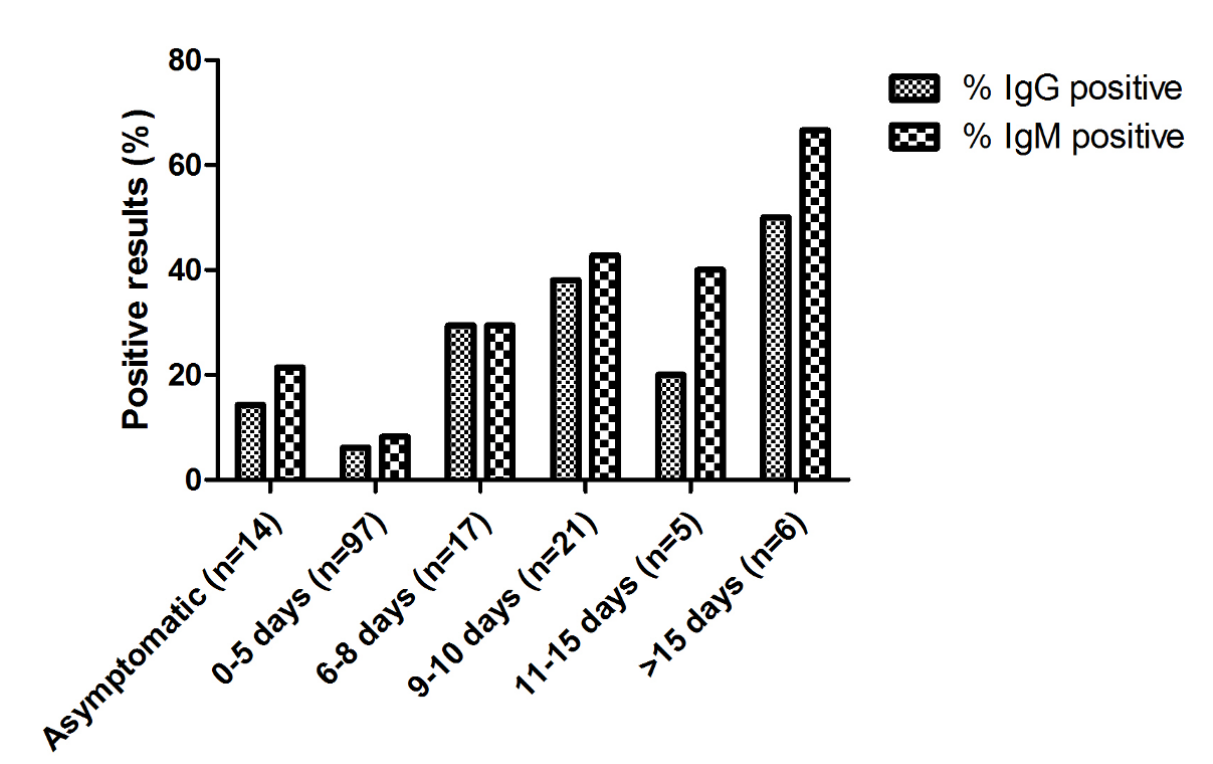
Figure 3. Bar plot depicting the distribution of the proportion of positive IgG and IgM VivaDiag test results according to time after symptom onset